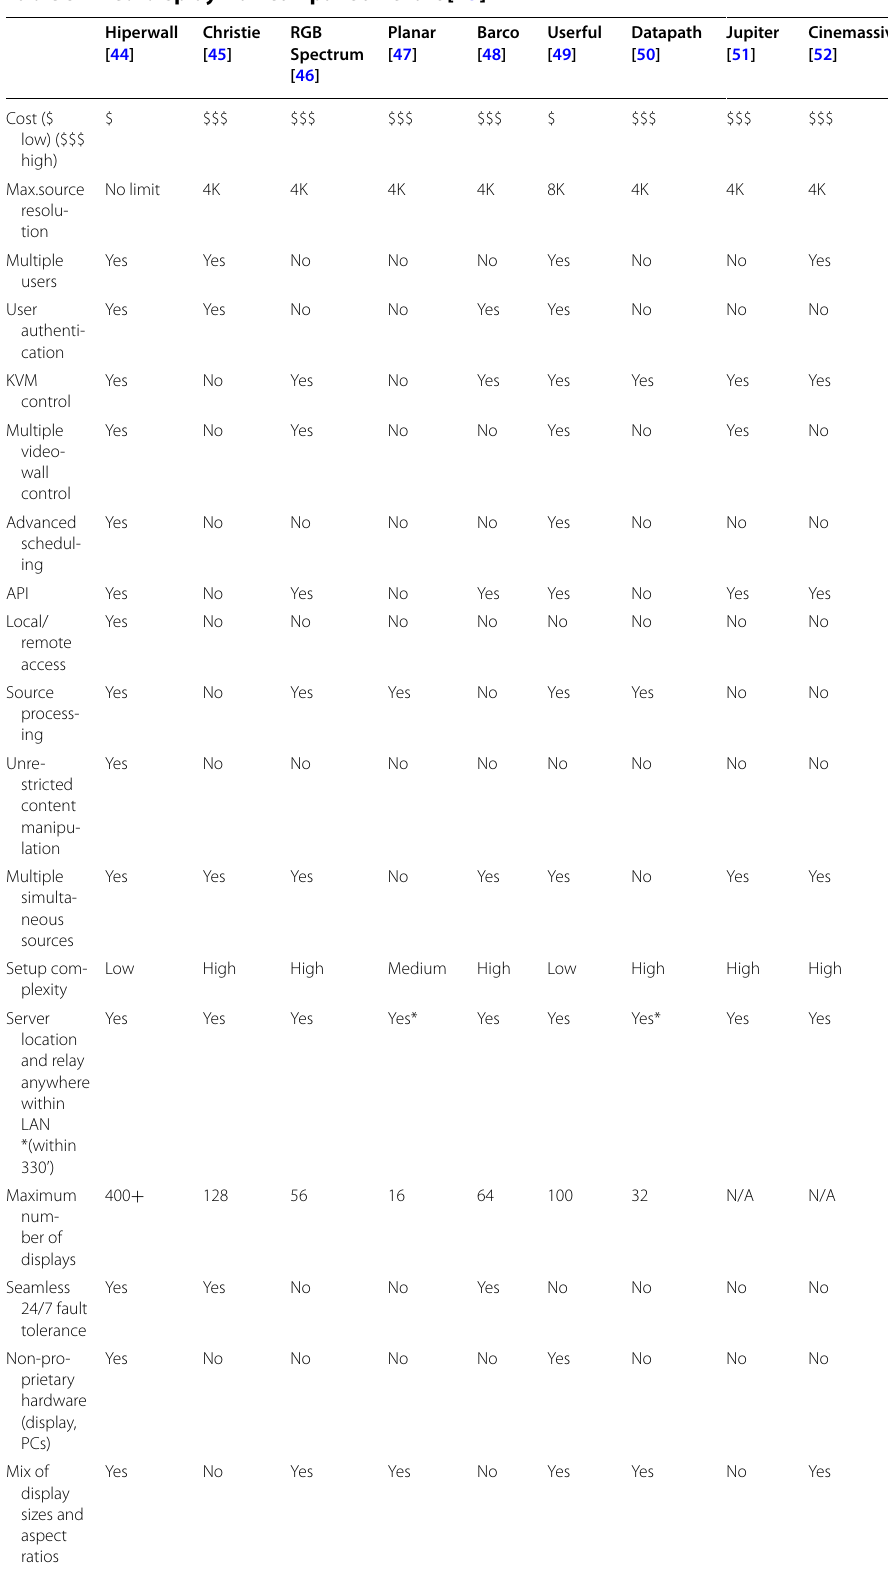
Table 3 Tiled-display wall comparison chart